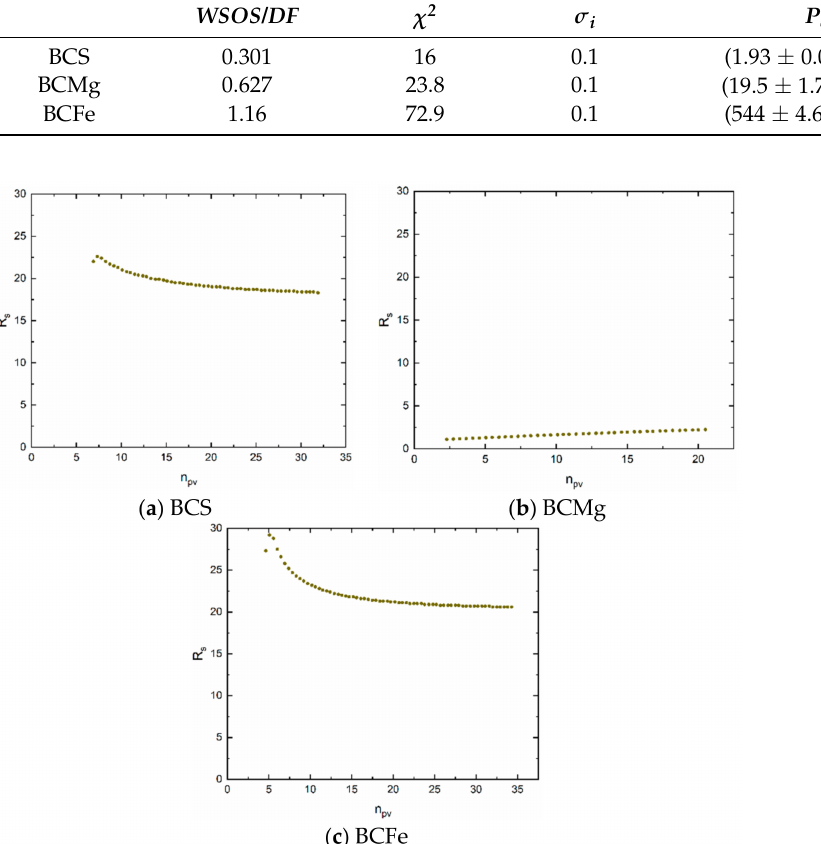
Figure 6. Retardation coefficients. ( a ) BCS, ( b ) BCMg, ( c )